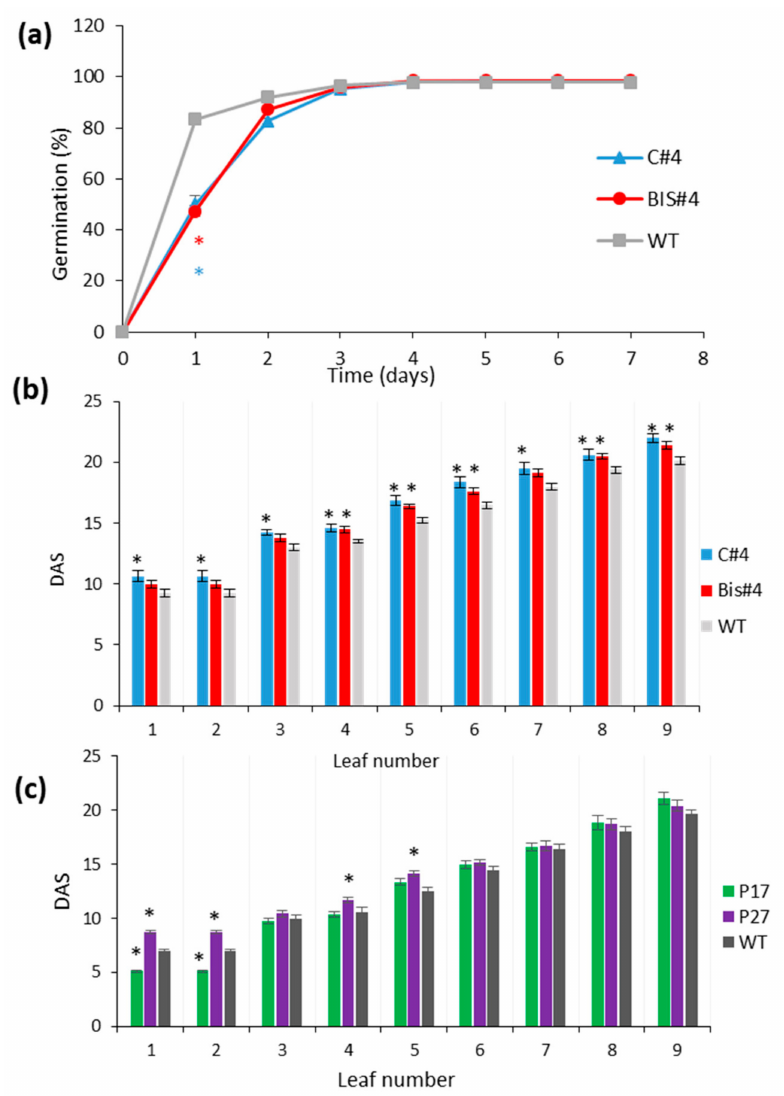
Figure 3. The e ff ect of AtCuAO δ mutation on germination and leaf emergence mutant lines (C#4 and BIS#4) and over-expressor lines P17 and P27 compared to WT: ( a ) the germination rate of mutants C#4 and BIS#4 (n = 5; 30 seeds / replicate); ( b ) leaf emergence in mutant lines C#4 and BIS#4 (n = 8); ( c ) leaf emergence in over-expressor lines P17 and P27 (n = 8–16). Significant di ff erences in means are indicated by * at p ≤ 0.05 based on a Student t -test. DAS is days after sowing, mean ±